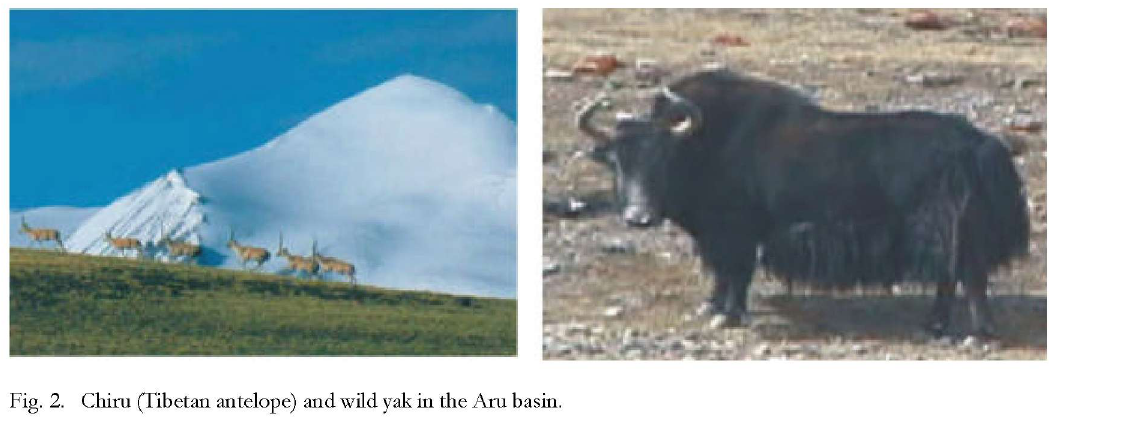
Fig. 2. Chiru (Tibetan antelope) and wild yak in the Aru